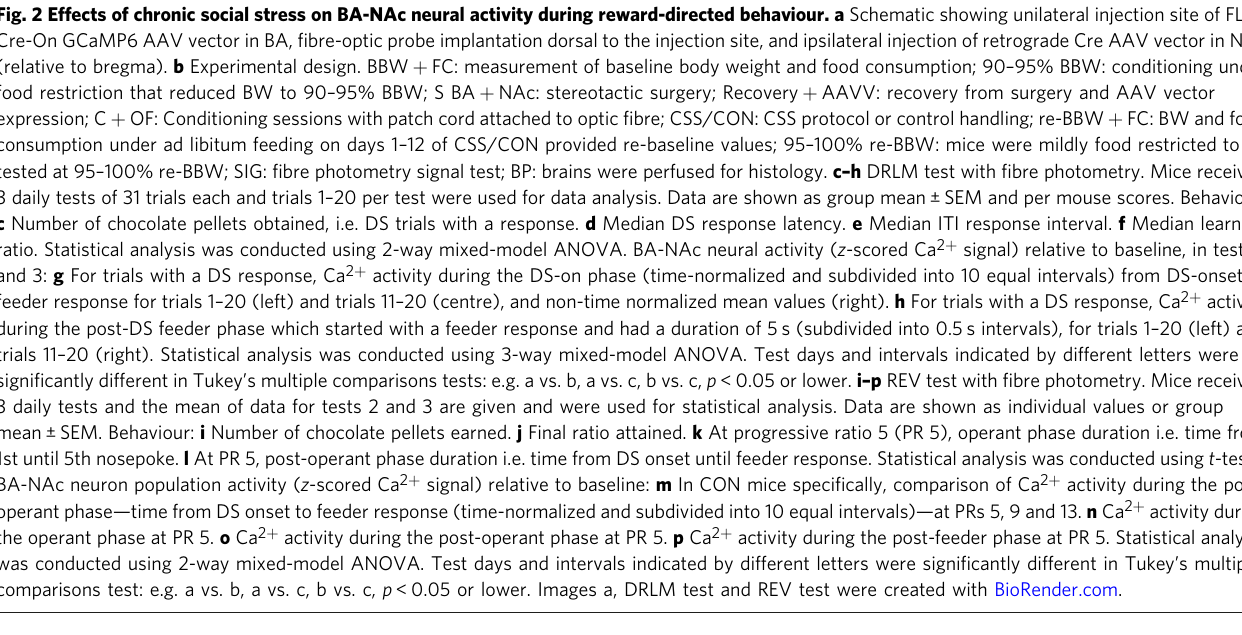
Fig. 2 Effects of chronic social stress on BA-NAc neural activity during reward-directed behaviour. a Schematic showing unilateral injection site of FLEX Cre-On GCaMP6 AAV vector in BA, fi bre-optic probe implantation dorsal to the injection site, and ipsilateral injection of retrograde Cre AAV vector in NAc (relative to bregma). b Experimental design. BBW + FC: measurement of baseline body weight and food consumption; 90 – 95% BBW: conditioning under food restriction that reduced BW to 90 – 95% BBW; S BA + NAc: stereotactic surgery; Recovery + AAVV: recovery from surgery and AAV